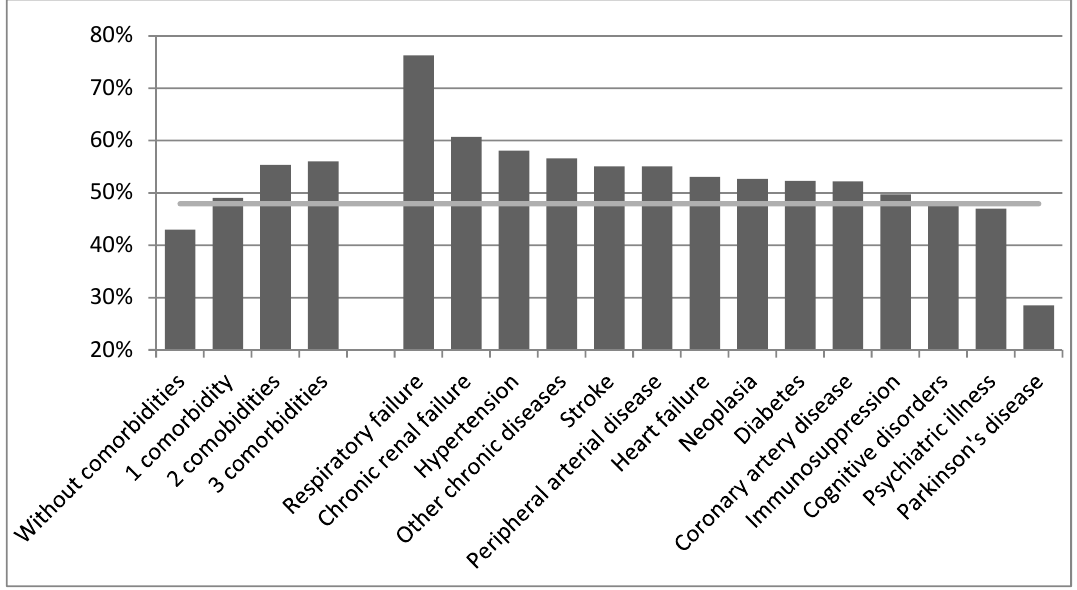
Figure 1. Influenza vaccine coverage according to comorbidities during the 2016–2017 season. The grey line indicates the mean rate of vaccination in the whole population.